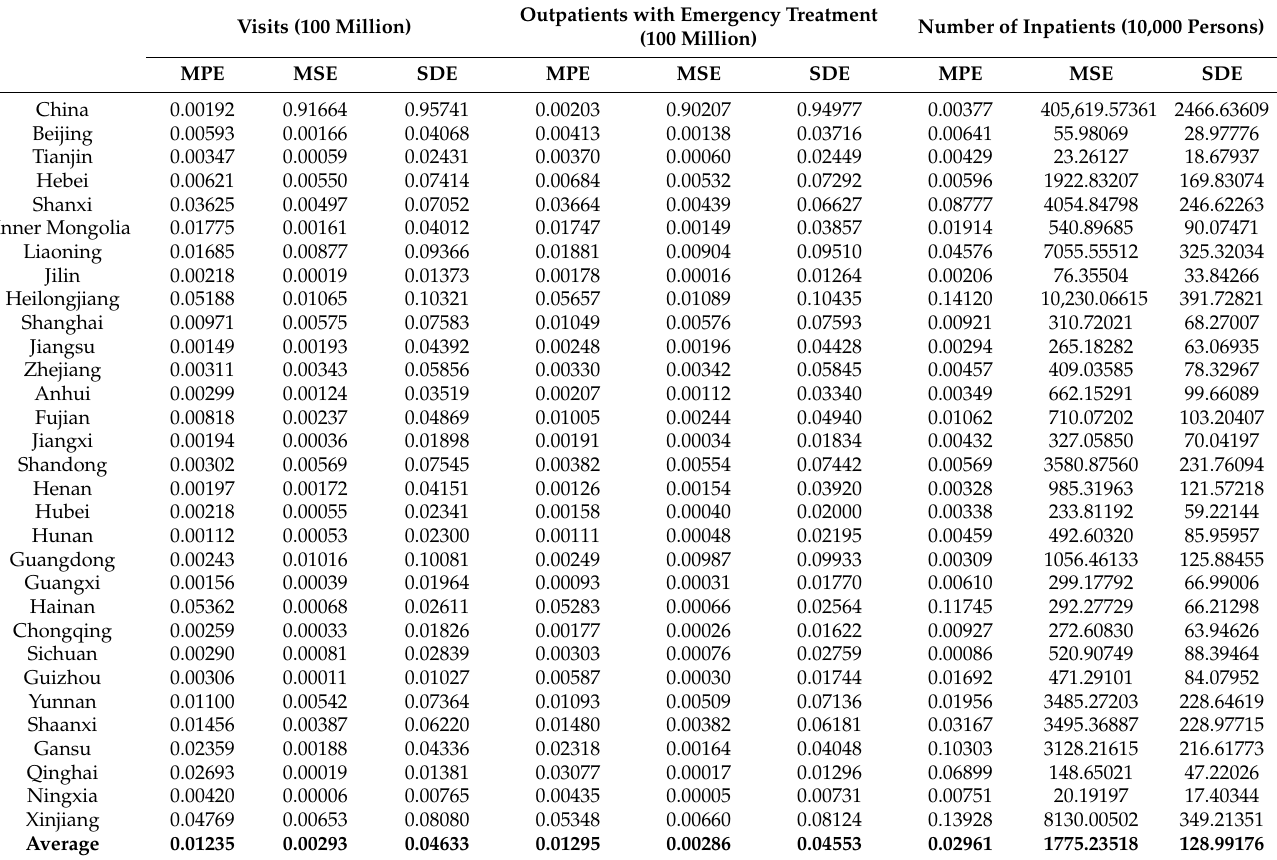
Table 1. The First Part of Forecasting performance of LS-SVM-FM (1). Visits (100